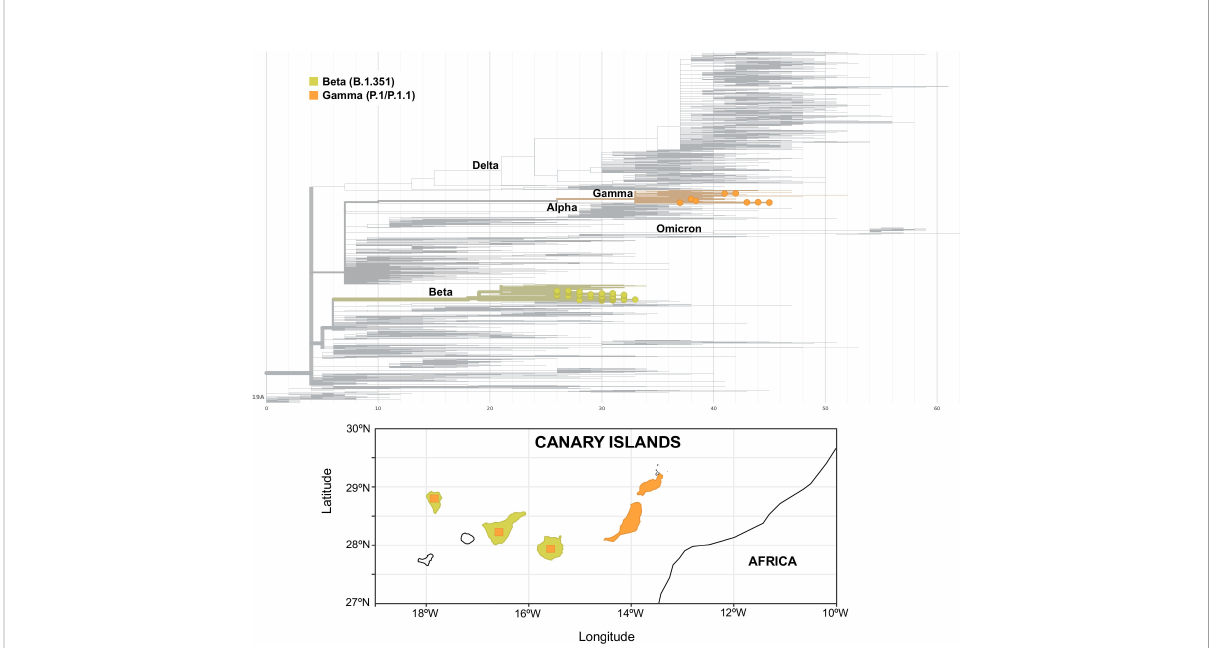
FIGURE 4 Phylogenetic tree of Beta (yellow) and Gamma (orange) variants (upper panel) and their distribution in the islands of the archipelago (lower panel). Square areas are proportional to the presence of the variant in each